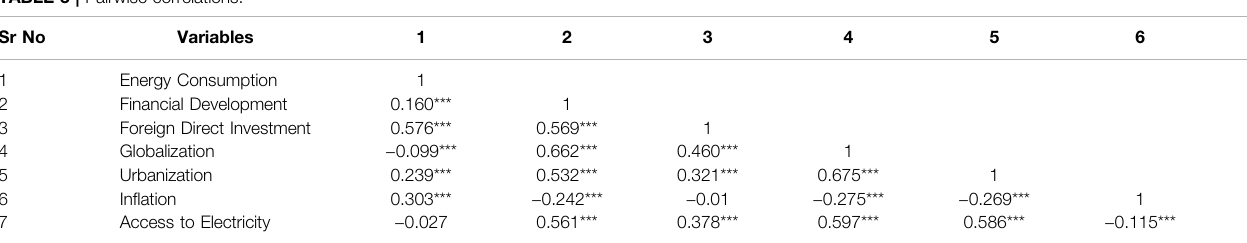
TABLE 3 | Pairwise correlations.